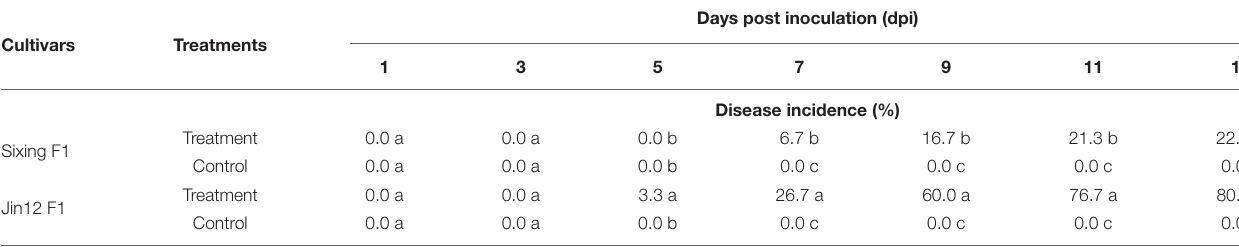
TABLE 2 | The disease incidence of different cultivars of Cucurbita pepo after inoculation with Podosphaera xanthii .